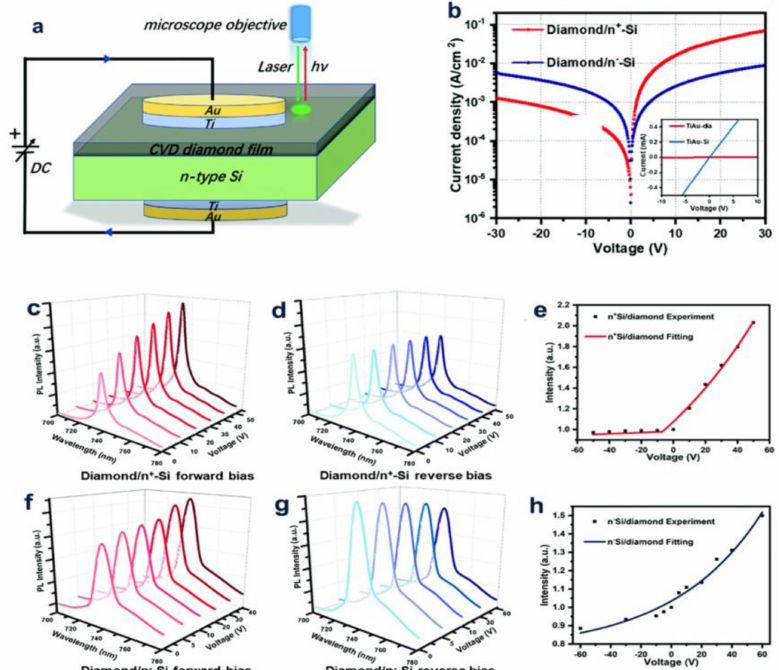
Figure 11. ( a ) Sketch map of making diamond-Si diode ( b ) corresponds to semilog J–V curves. The PL spectra of the SiV − centers in the diamond/n+-Si ( c – e ) and diamond/n - -Si ( f – h ) heterojunctions under various bias voltages: ( c , f ) forward bias; and ( d , g ) reverse bias. ( e , h ) The plot of the SiV - ZPL strength as a function of the bias